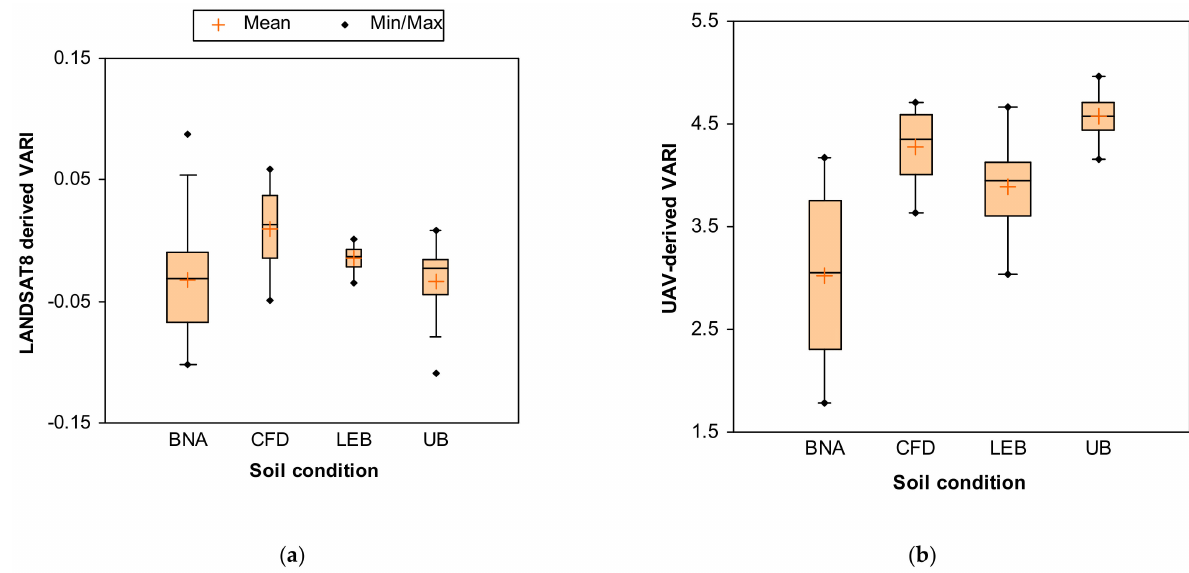
Figure 8. Mean values of VARI surveyed by LANDSAT8 ( a ) and UAV ( b ) images (2016) among four land conditions after the wildfire of 2012 in Sierra de Los Donceles forest (Castilla-La Mancha,